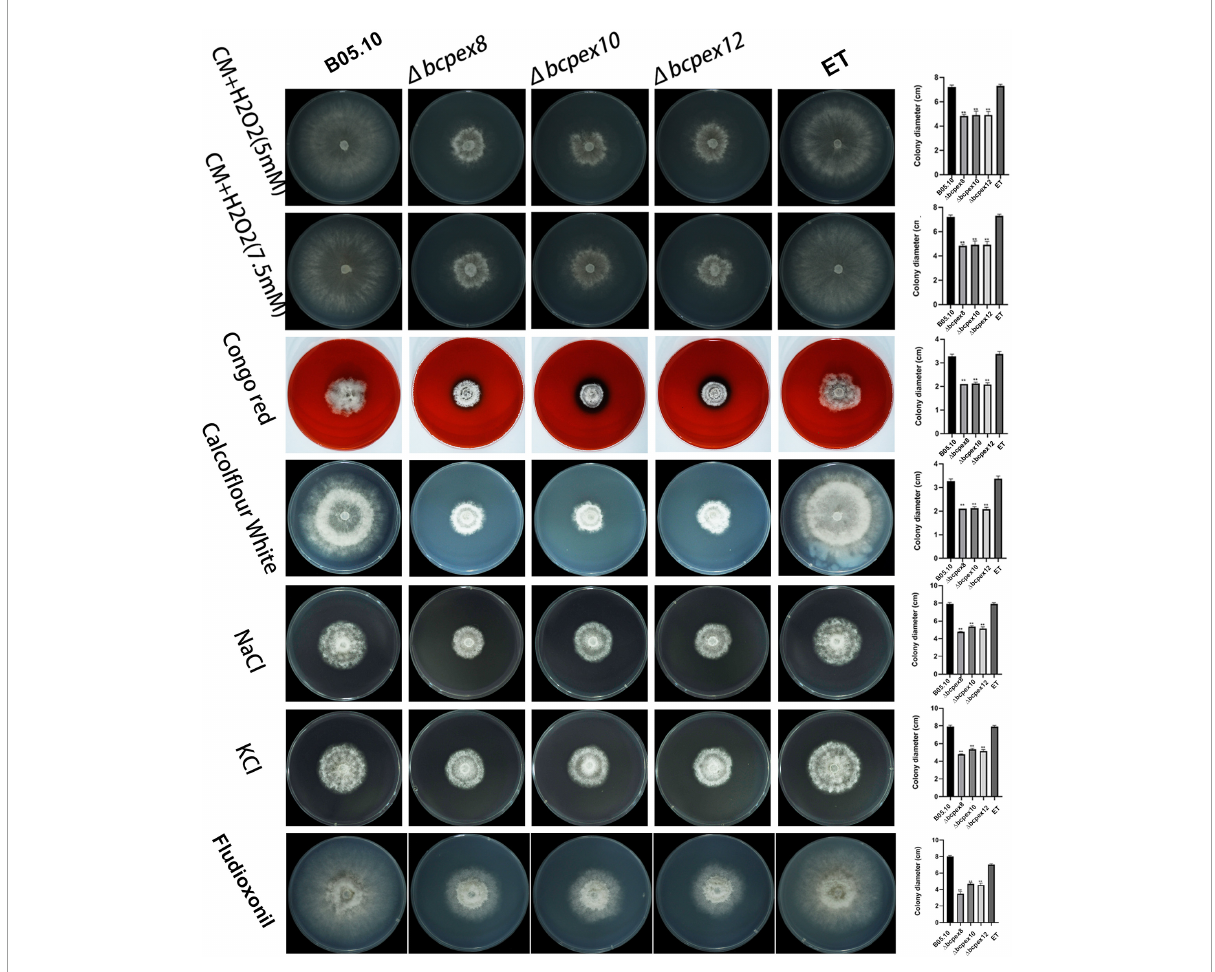
FIGURE6 Tolerance test of (cid:49) bcpex8 , (cid:49) bcpex10 , and (cid:49) bcpex12 mutants and WT and ET strains to osmotic and oxidative stress, cell wall interference agent, and fludioxonil. The strains were cultured on CM plate supplemented with 5 or 7.5 mM H 2 O 2 , 200 µ g/ml Congo red, 50 µ g/mL Calcofluor white, 1 M sodium chloride or 1 M potassium chloride, or 0.05 µ g/ml fludioxonil and were observed at 4 dpi (** p <